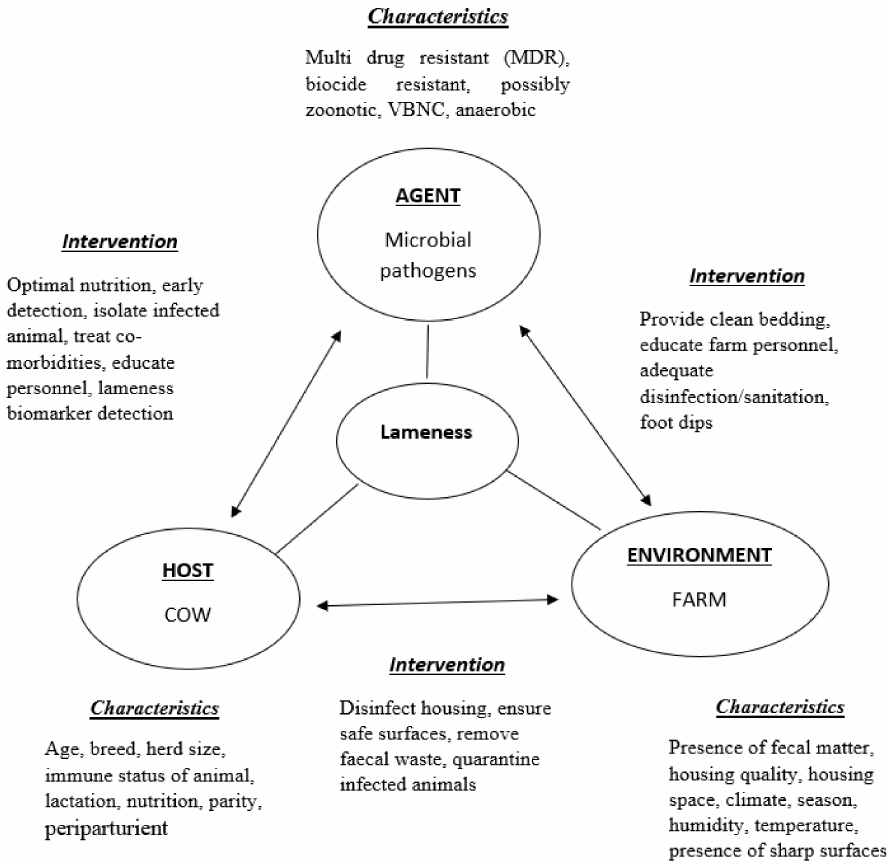
Figure 1. Factors contributing to lameness in dairy cattle, associated characteristics, and intervention methods for disease prevention on dairy farms. MDR = multi-drug resistant, VBNC = viable but non